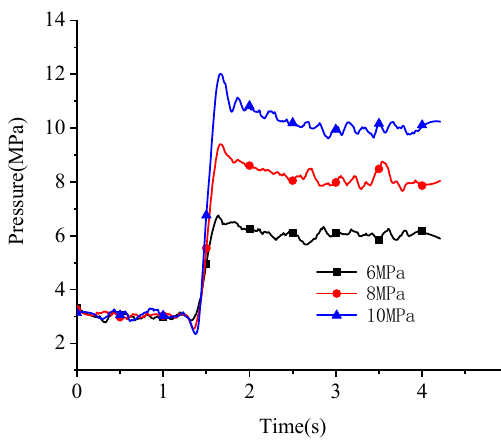
Figure 23. Step change curve of the outlet pressure.